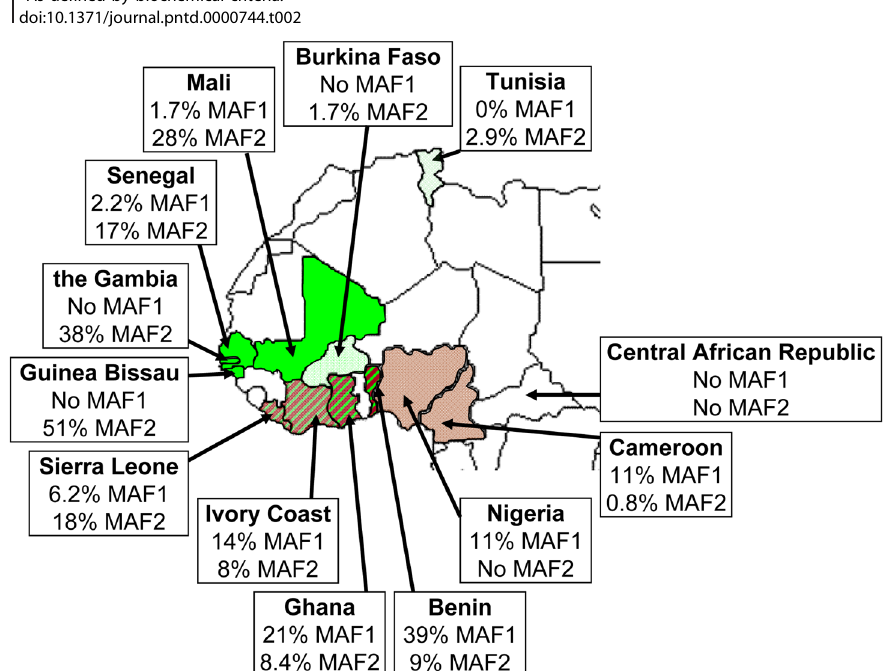
Figure 3. M.africanum prevalence in Western African countries. Prevalence figures were derived from the most recently published studies from Table 2 and unpublished data from Tunisia, Senegal, Cote d’Ivoire, Cameroon, and the Central African Republic extracted from the